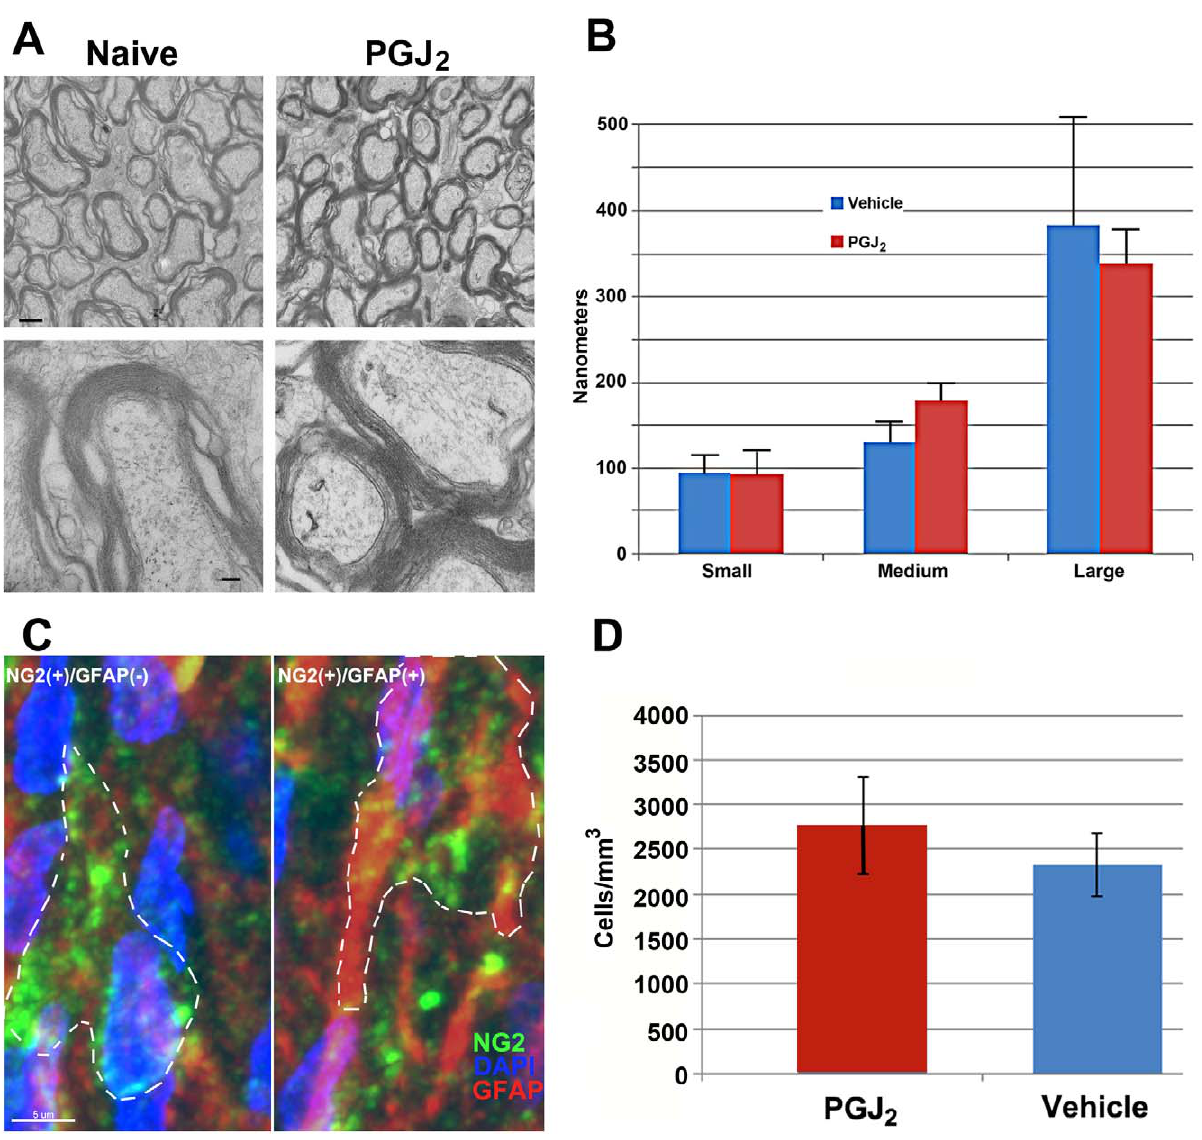
Figure 9. Oligodendrocyte- ultrastructural and -precursor analysis in vehicle- and PGJ 2 -treated ONs. Animals were euthanized 30 days post-treatment and tissues prepared for either TEM (A and B) or immunohistochemistry (C and D) (see methods). A (top panels): low magnification of ON from either vehicle or PGJ 2 -treated animals. (bottom panels): High magnification of ON from vehicle- and PGJ 2 - (blue bars) treated animals. B. Myelin thickness graph from the ONs of vehicle- (red bars) and PGJ 2 - (blue bars) treated animals (Figure 9B). Axons from three distinct size group (small, medium, and large axons/group) were evaluated (n=5 axons/group). Mean thickness is similar in each group for both conditions. Mean 6 sd. C. Confocal analysis of NG2( + )/GFAP( 2 ) (presumed oligodendrocyte precursors) and NG2( + )/GFAP( 2 ) (Presumed astrocyte precursors) from the ON of a naı¨ve animal. Both NG2( + ) (Cy5 secondary label, seen in green)- GFAP( 2 ) and GFAP( + ) (Cy3 secondary label, seen in red) cells are scattered throughout the ON in naı¨ve- and PGJ 2 - treatment groups. D. Stereological analysis of NG2 expressing cells in vehicle- and 30 day post-PGJ 2 treated ONs (n=5 nerves/group) showed similar numbers of NG2( + )/GFAP( 2 ) cells per unit volume. p . 0.05, Mann-Whitney U test.